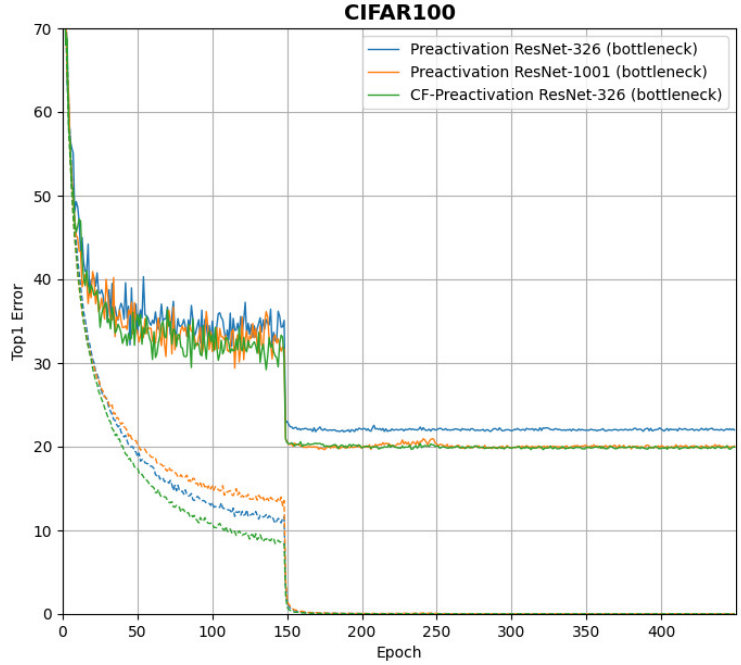
Figure 2. Comparison with the CIFAR-100